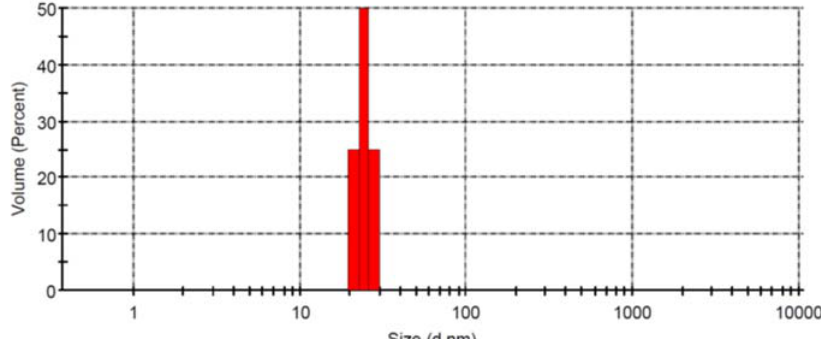
Figure 1. Size distribution of AgNPs. The size distribution of AgNPs was determined using a Malvern Zeta Sizer at a concentration of 1.6 mg/mL in water. Data are expressed as mean ± SEM ( n = 3).